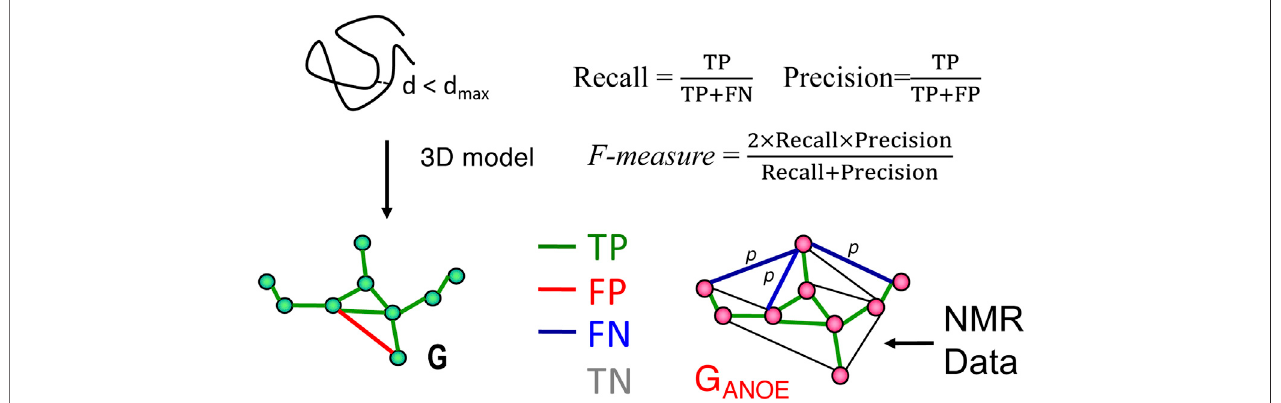
FIGURE 1 | SchematicdescriptionofRPF-DPscores.Inthisanalysis,thegraphGwithnodescorrespondingtoall 1 H ’ sandedgesrepresentingallshort(e.g., < 5 Å) 1 H- 1 H distances in a structure model (left), is compared with a graph G ANOE (right), in which nodes again correspond to all 1 H ’ s, and edges describe all possible assignments for each NOESYcrosspeak.Truepositives(TPs)areedgescommontobothGandG ANOE ,falsepositives(FPs)areedgespresentinGbutnotinG ANOE ,andfalsenegatives(FNs)arethe setofedgesinG ANOE representingthemultiplepossibleassignmentsofaNOESYcrosspeak,noneofwhicharepresentinG.Thesemetricsareusedtocomputerecall(R), precision(P),andF-measureasshowninthe fi gureandoutlinedintheMethodsSection.TheF-measureistheharmonicmeanoftherecallandprecision.TheDiscriminatingPower (DP)isanormalizedF-measurecorrectedtoaccountfortheF-measureexpectedforarandom-coilchain(DP=0)andthebestF-measurepossibleconsideringthecompleteness oftheNMRdata(DP=1.0).SinceNOESYdataisrestrictedtoshortdistances(e.g., < 5 Å),truenegatives(TNs,peaksnotexpectedfromthemodelandnotobservedintheNOESY data) can dominate these statistics and are not included in these recall, precision, and F-measure metrics. Figure and legend are adopted from Huang et al.